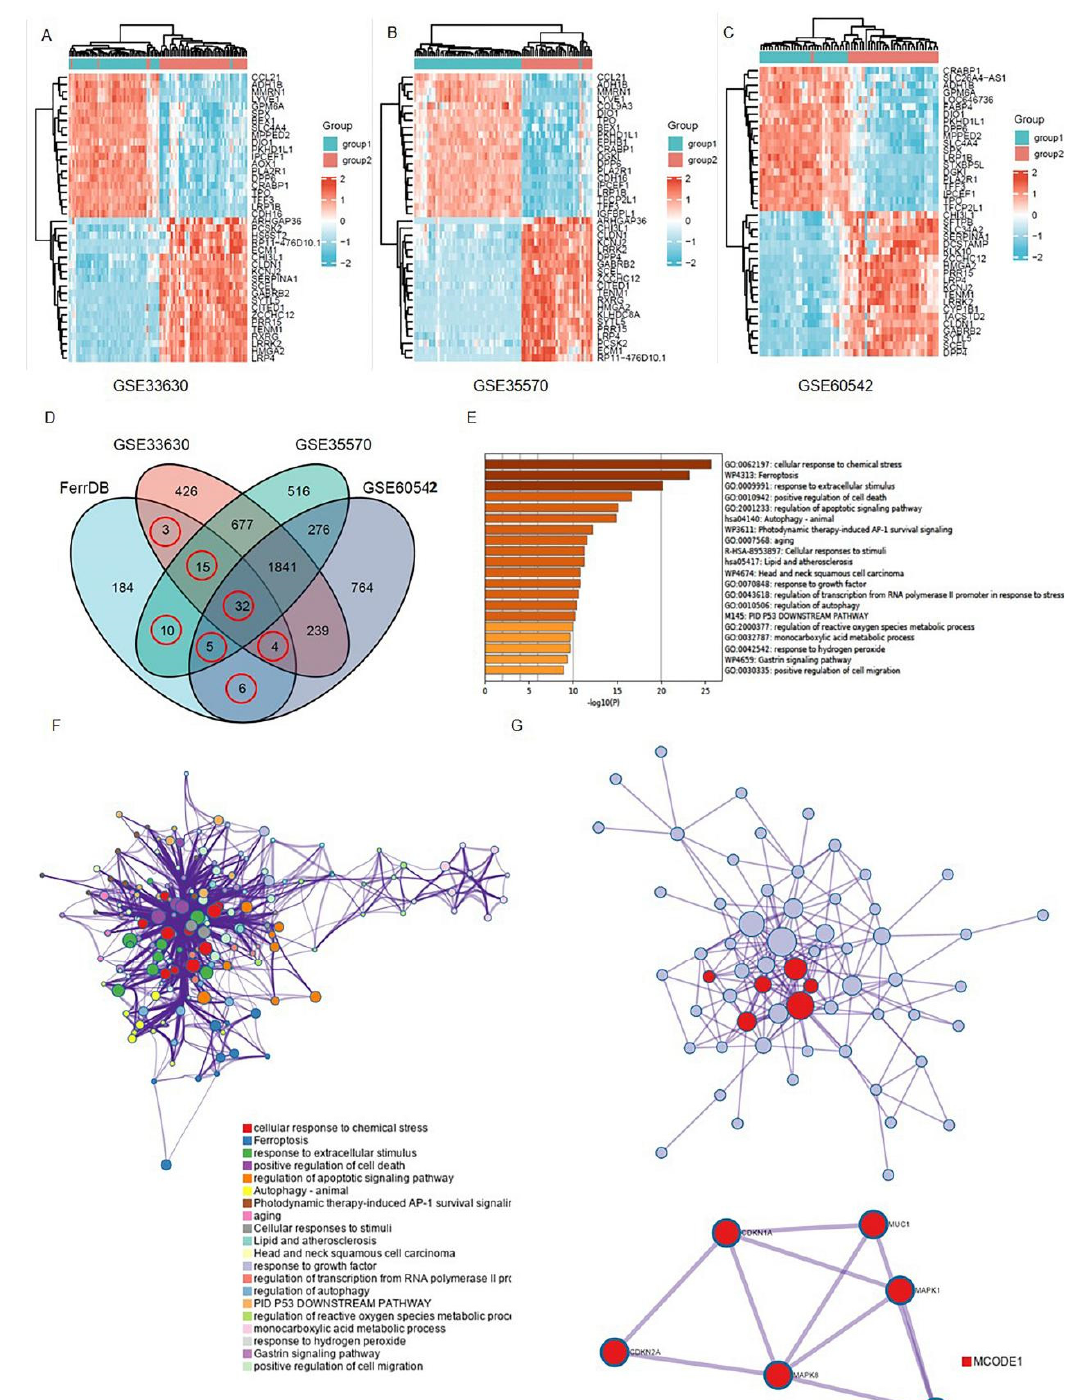
Figure 1. Brief summary of the ferroptosis signals that are differentially expressed in THCA: ( A – C ) Ferroptosis-related gene expression profiles in normal and tumor samples in the datasets. The expression of genes was used to group them together. High expression is represented by red, whereas low expression is represented by blue; ( D ) a Venn diagram depicting the dysregulated ferroptosis genes that were found in all four datasets; ( E , F ) a graph depicting the GO and KEGG analyses based on Metascape Online, as well as a bar plot and a network depicting the distribution and relationships between the various functions; ( G ) the hub genes in the ferroptosis gene collection are shown in the PPI network and MCODE. Red balls are MCODE1.